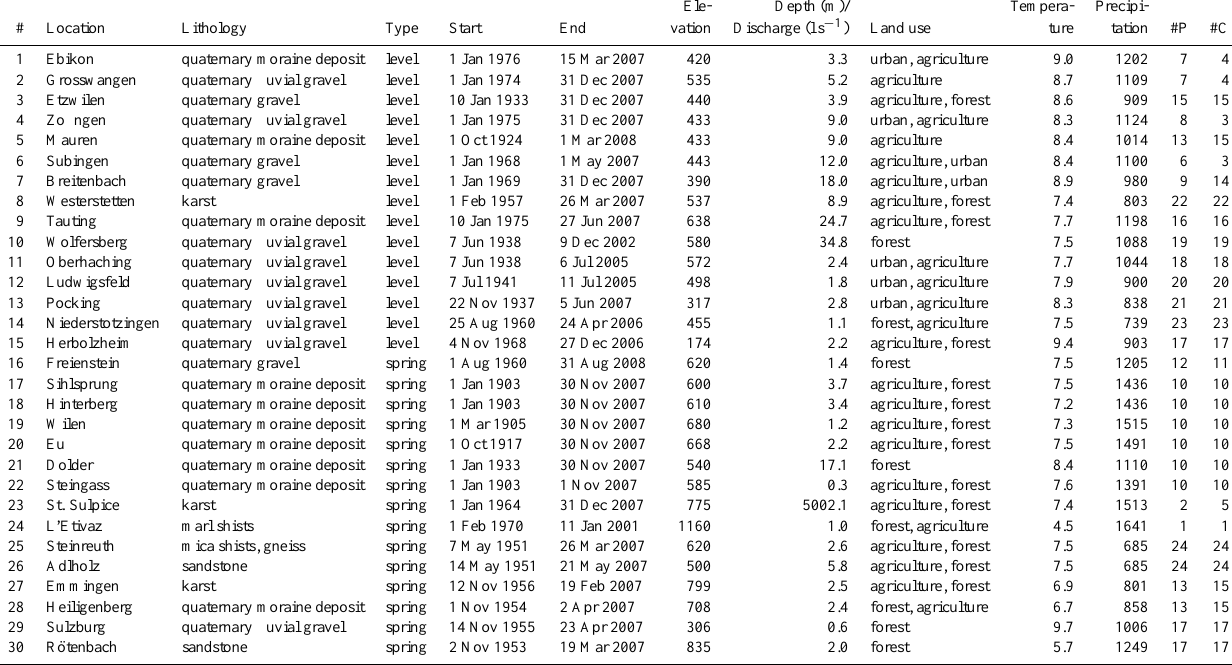
Table 1. Analyzed groundwater time series (see also Fig. 1 for the exact locations) with elevation (ma.s.l.), average groundwater depth in meter below terrain (Depth/Discharge) or mean annual discharge (ls − 1 ) , mean annual precipitation in mma − 1 (1971–1990), mean annual temperature in ◦ C (1971–1990) and the number of the precipitation (#P) and climate station (#C), used to calculate the recharge .